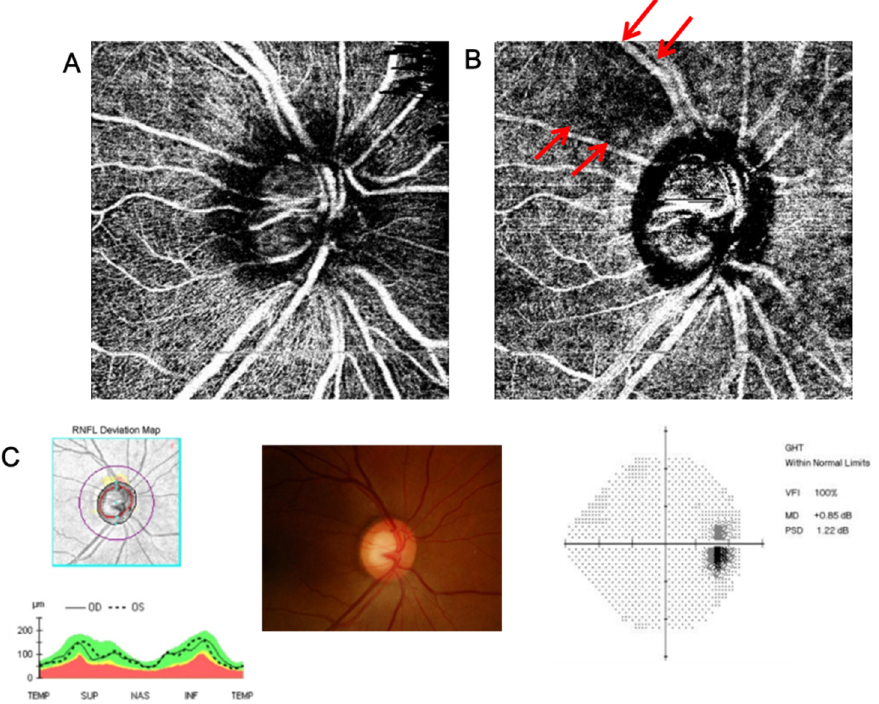
Figure 1. ( A ) Superficial peripapillary OCT angiography in the superficial layer (from the retinal nerve fiber layer (RNFL) to 130 μ m below the internal limiting membrane (ILM) including the ganglion cell-inner plexiform (GCIPL) layer). ( B ) Deep peripapillary OCT angiography in the deep layer (from 130 μ m below the ILM to the basement membrane including the inner nuclear layer (INL)). ( C ) RNFL OCT and visual field test with increased cup-disc ratio (CDR) which indicate glaucoma suspect. There are subjects among glaucoma suspect patients with wedge-shaped VD defect in the deep layer of peripapillary area (indicated as arrows in B ), even though the vessel density in the superficial layer is unaffected (intact vascular status in A ).